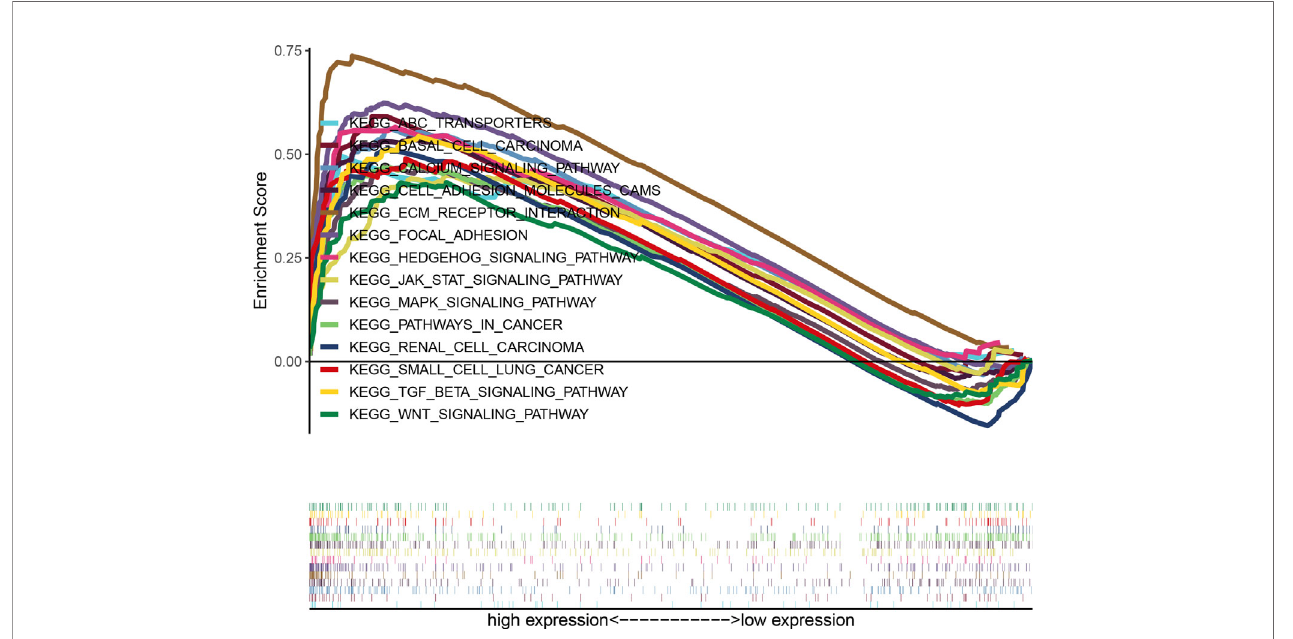
FIGURE 6 | Enrichment plots of multiple signaling pathways from GSEA. Signi fi cantly enriched signaling pathways were ECM receptor interaction, Calcium signaling pathway, Focal adhesion, Basal cell carcinoma, Hedgehog signaling pathway, MAPK signaling pathway, TGF- b signaling pathway, Pathway in cancer, Cell adhesion molecule, Renal cell carcinoma, JAK-STAT signaling pathway, ABC transporters, Small cell lung cancer, Wnt signaling pathways. GSEA, gene set enrichment